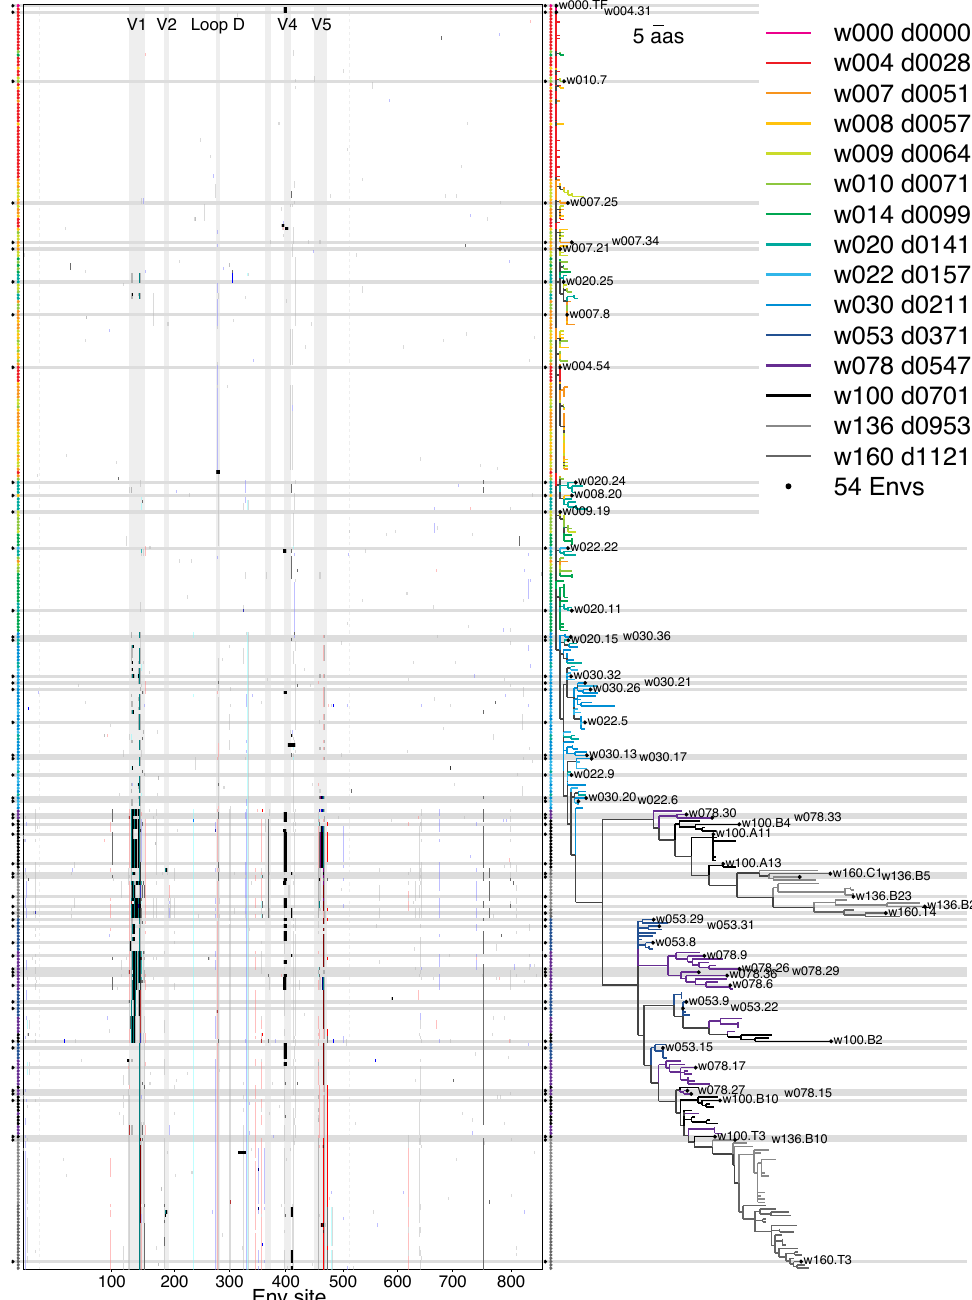
Figure 7. Env variants in phylogenetic context. A pixel plot is paired with the maximum-likelihood phylogeny, such that each row depicts one of 385 Envs sequenced by limiting-dilution PCR. The top row corresponds to the TF virus. In the pixel plot (left), sites that match the TF are blank and mutations are shaded indicate gain of negatively (red) or positively charged amino acids (blue), addition of an N-linked glycosylation motif (cyan), indels (black), or other mutations (grey). The colored vertical stripes that emerge with time correspond roughly to TF loss. Env landmarks appear as vertical bands throughout the pixel plot (light grey), and dashed line delineates the boundary between gp120 and gp41. Tree branches and symbols are color-coded to indicate sample time-point, and the 54 selected Envs are marked by a black circle and horizontal bar. HXB2 numbering is used here and throughout, beginning with the Env signal peptide start codon in column one and ending with the stop codon at position 857. This visualization was produced by the pixelgram package; see Section 4.4 for